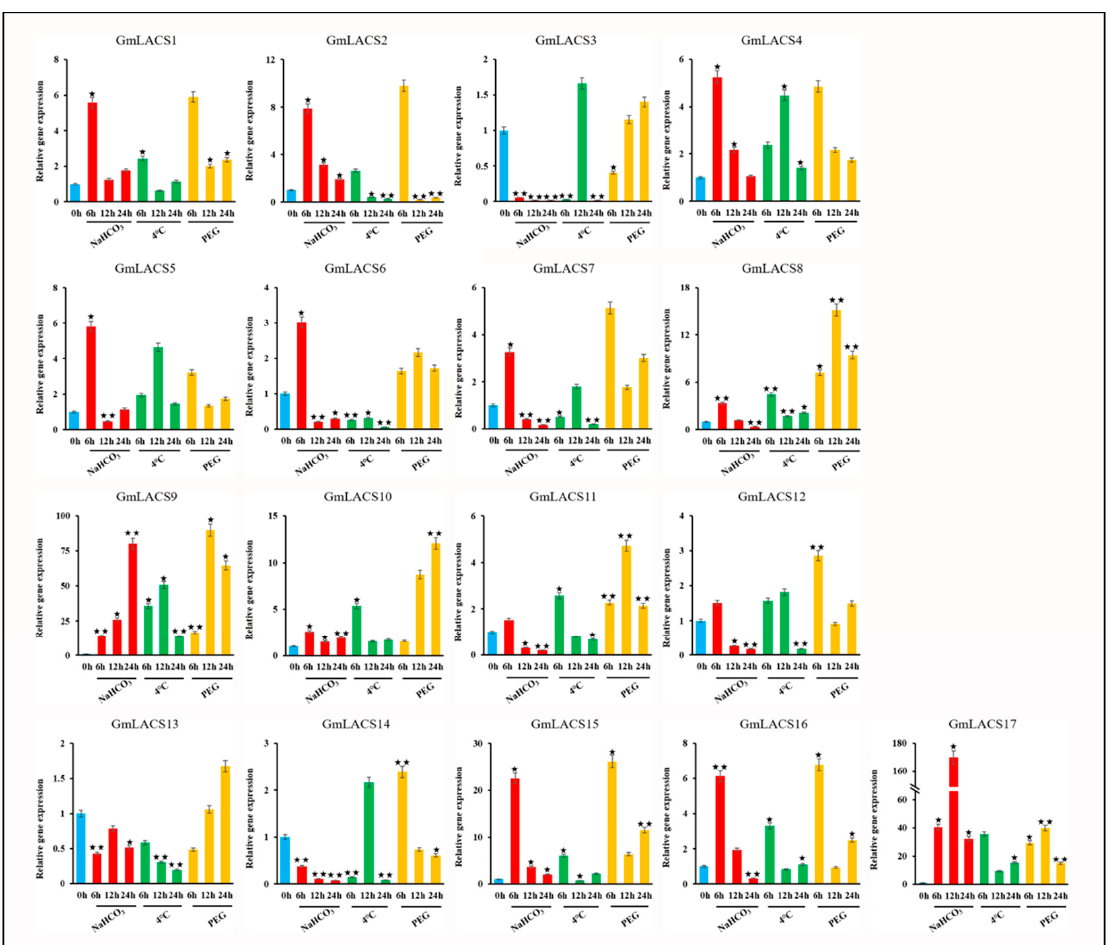
Figure 6. Expression profiles of GmLACSs at 4 °C, 100 mM NaHCO 3 , 20% PEG and water (control) for 0, 6, 12 and 24h. The expression of GmLACSs in non-stress conditions was used as a calibrator. Three separate biological replicates, qRT-PCR results were analyzed by 2 −∆∆ ct method. Asterisks on the bar chart indicate statistically significant differences in Student’s t -test (* p < 0.05, ** p < 0.01).